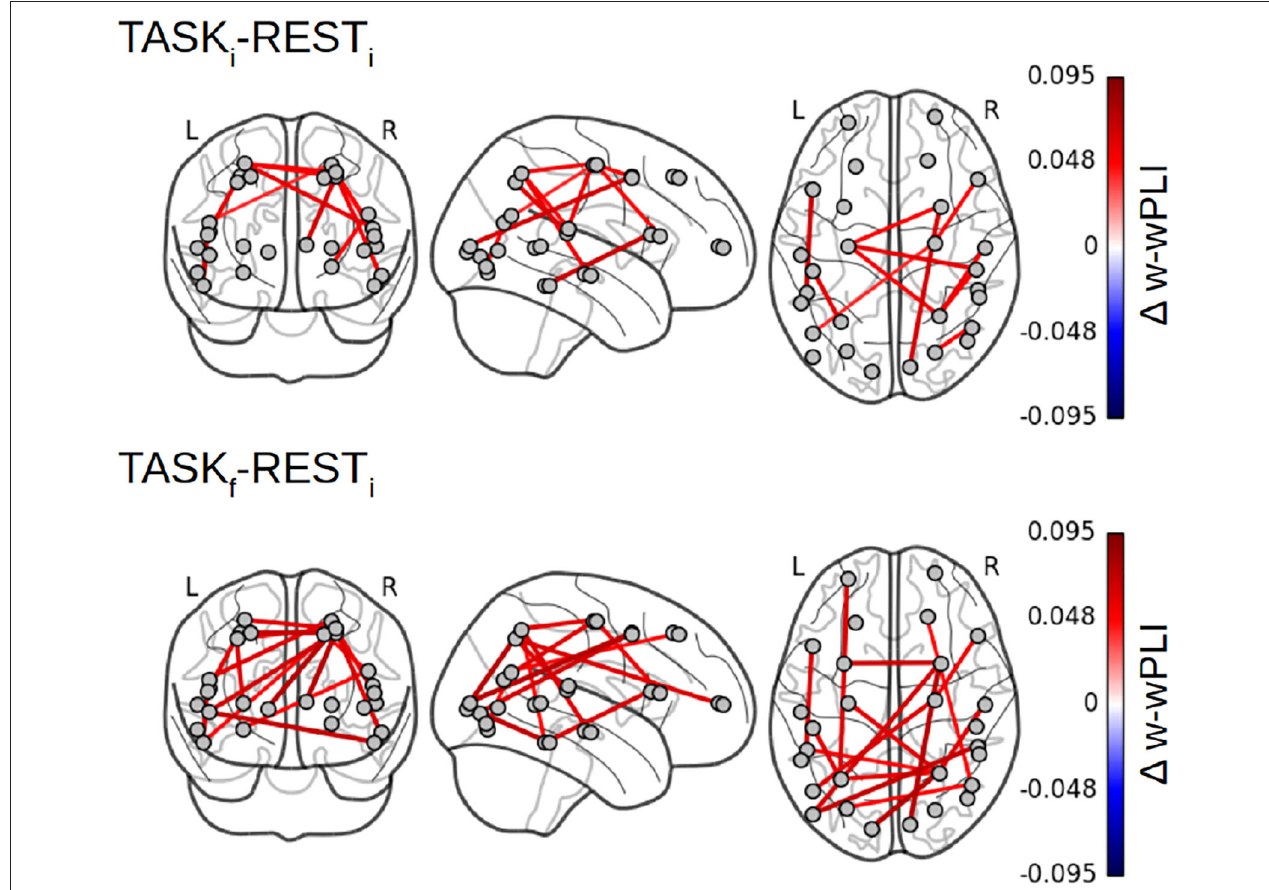
FIGURE 8 | Fractal dynamics-based functional connectivity assessment (W-wPLI) differences between REST i and TASK i and between REST i and TASK f . The increase in functional connectivity assessed from fractal dynamics from rest to task is strengthened with training, i.e., from TASK i to TASK f , and emerged between several intra- or inter-hemispheric pairs of regions (Frontal polar/IPS, ITC/MT, FEF/pSTS) involved in task performance.